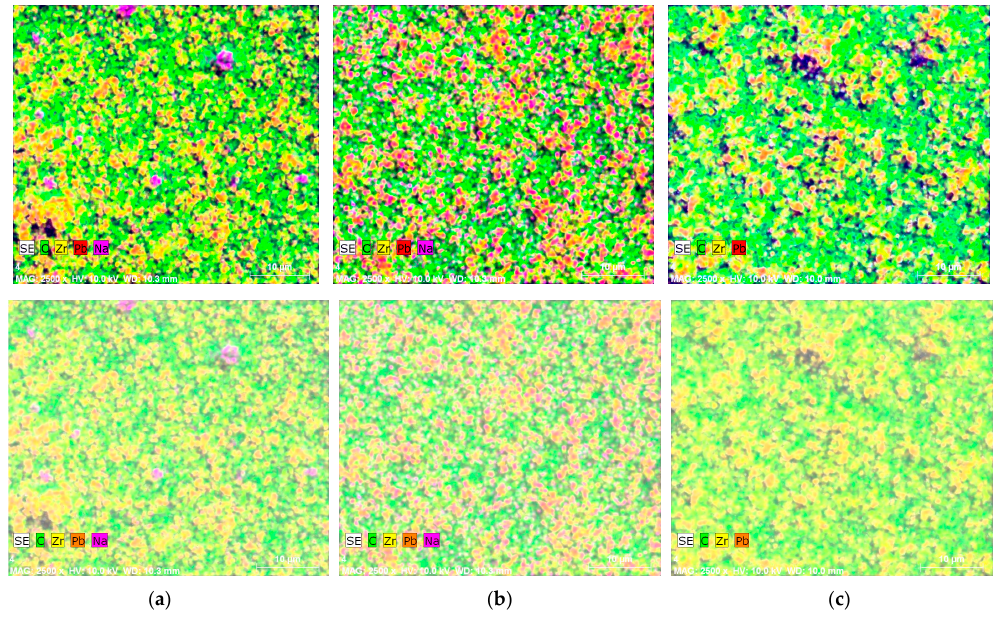
Figure 7. Elemental mapping done with SEM of the ( a ) Element 1 (mesh 32/70); ( b ) Element 2 (mesh 48/70); ( c ) Element 3 (mesh 140/34).